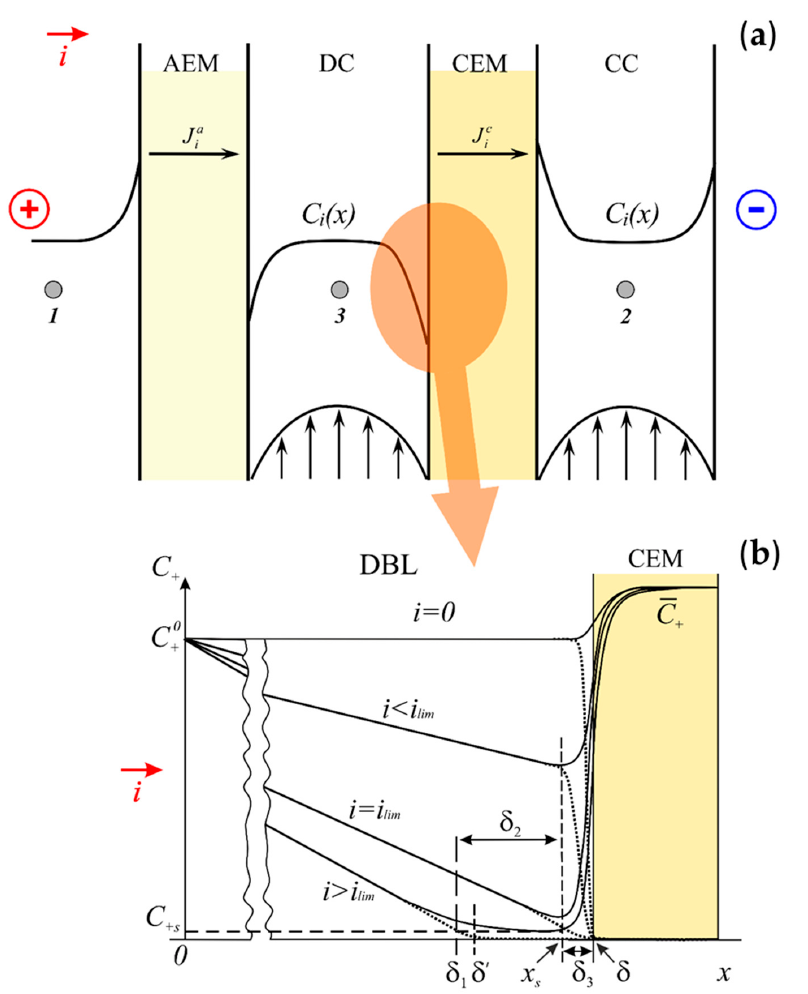
Figure 1. An electrodialysis cell with anion-exchange membranes (AEM) and cation-exchange membranes (CEM) forming desalination (DC) and concentration (CC) compartments ( a ); concentration profiles of a salt counterion in the di ff usion boundary layer (DBL) at a CEM schematically shown at di ff erent current densities ( b ). “1”, “2”, and “3” indicate the points between which the potential drop is determined. δ (cid:48) is the e ff ective DBL thickness; δ 1 , δ 2 , and δ 3 are the thicknesses of the electroneutral zone, extended space charge region (SCR), and the equilibrium part of the electric double layer, respectively, of the DBL. Redrawn from [68].